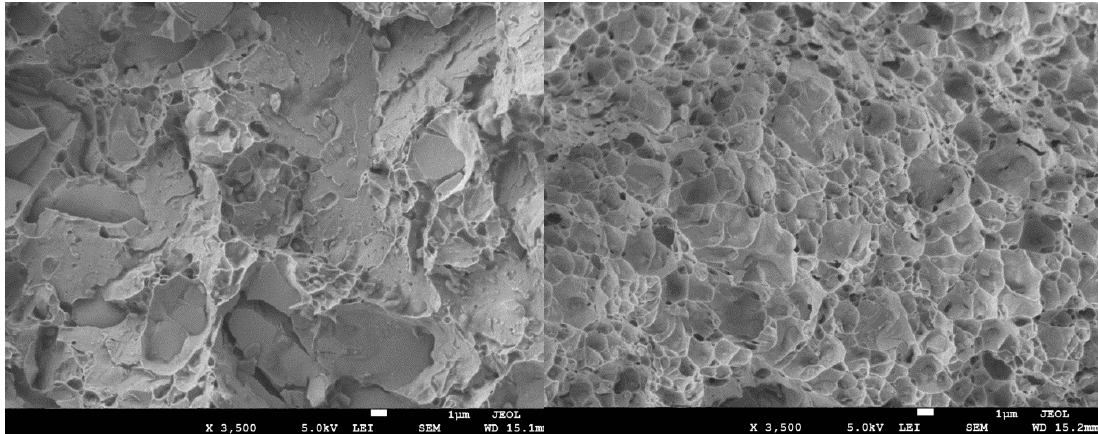
Figure 10. SEM morphologies of fracture surfaces of “D2” ( left ) and “O1” ( right ) with ×3500 magnification.